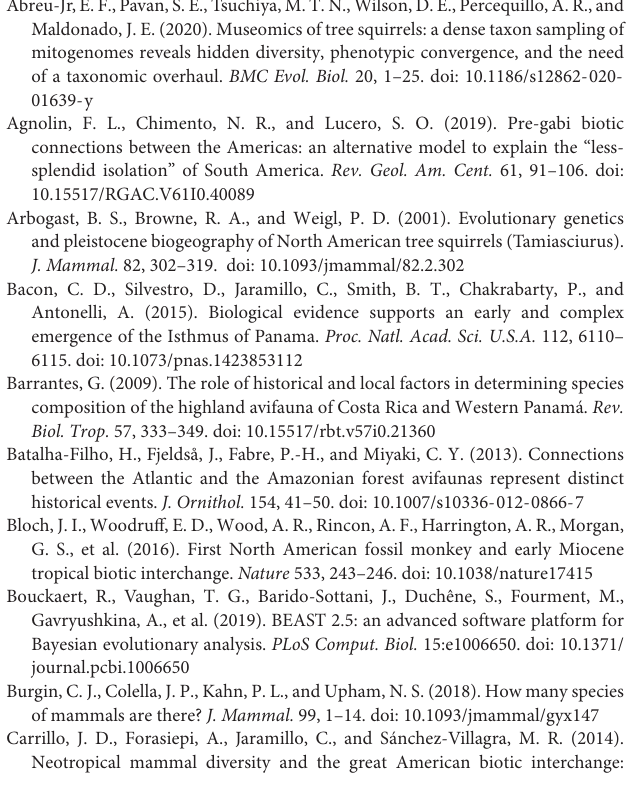
FIGURE S5 | Chronogram employed on the range evolution estimation of Sciurini on a Neotropical scale, showing the numbers of the nodes. FIGURE S6 | The most probable biogeographical scenario for Sciurini based on the set of ancestral ranges that received the highest likelihood in the Neotropical scale analysis, as inferred by BAYAREALIKE + J model. Colors in key boxes and map correspond to coloring of boxes within the tree (most probable ancestral ranges) and at terminals (current distribution of species). TABLE S1 | List of specimens analyzed in this study, with geographic information and GenBank accession numbers for complete mitochondrial genomes. Taxonomic identifications follow Abreu-Jr et al. (2020). Voucher acronyms refer to the following scientific collections: American Museum of Natural History,